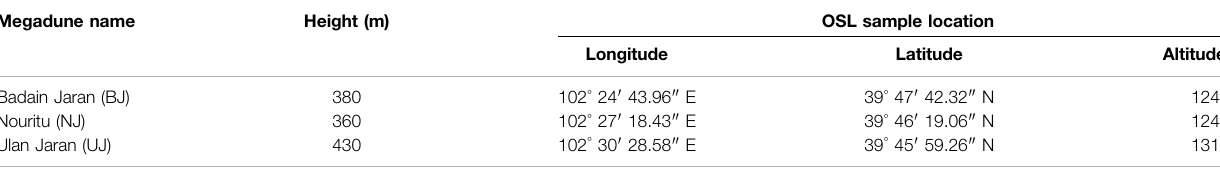
TABLE 1 | Geographical information of the OSL sampling localities.